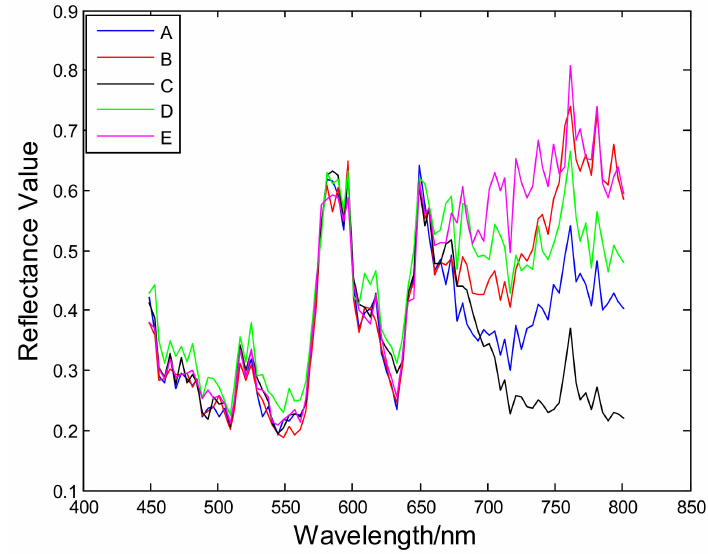
Figure 4. Spectral reflectance of A, B, C, D, E in visible light band. The grayscale images of different wavebands obtained by near-infrared imaging spectrometer are shown in Figure 5, below, and the spectral reflectance curves of different ground objects are shown in Figure 6.